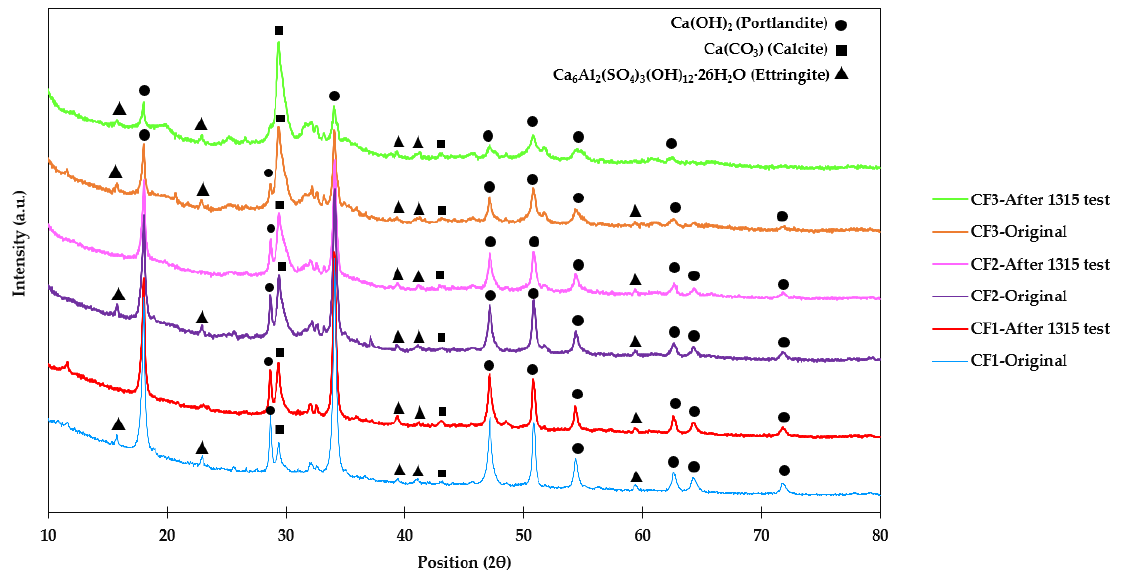
Figure 7. XRD spectra of CF1, CF2, and CF3 before and after the 1315 test.